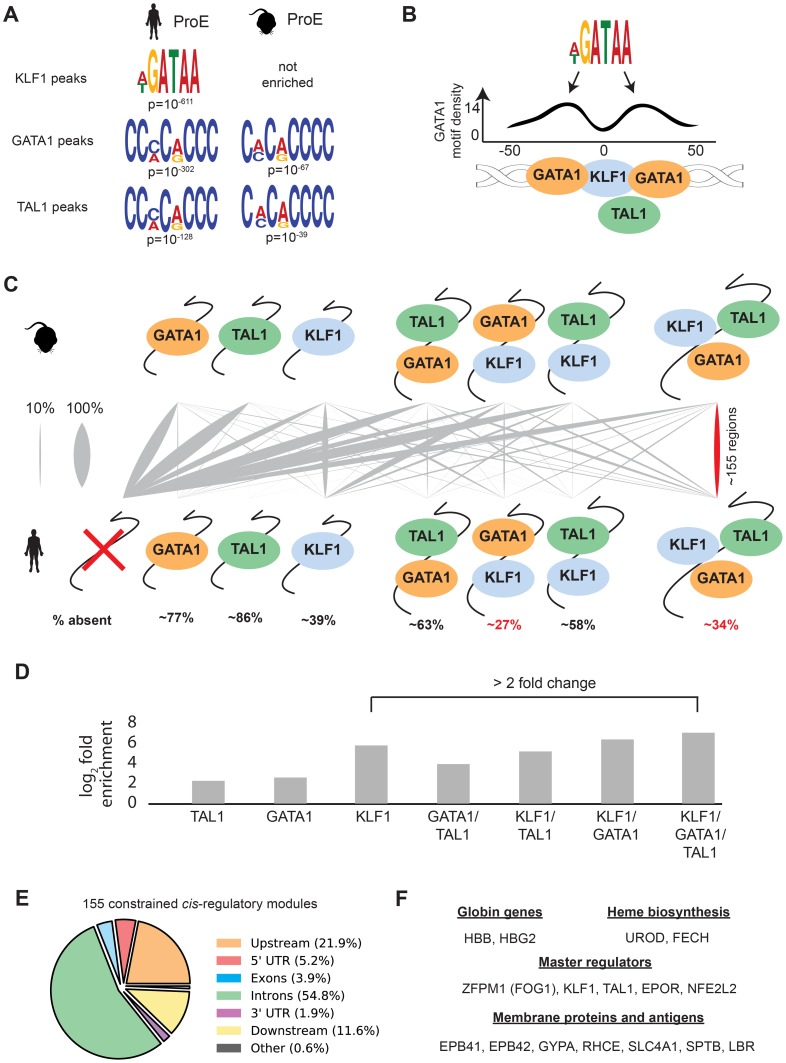
Combinatorial occupancy patterns of transcription factors are strongly conserved.A) In human ProE KLF1 peaks (summit +/- 50 bp), GATA1 motifs were significantly enriched. In human and mouse ProE GATA1 and TAL1 peaks, certain KLF1 motifs were significantly enriched. B) Enrichment of GATA1 motifs identified in A) at non-random distances from the summit of KLF1 occupancy sites reveals that GATA1 and GATA1/TAL1 occupancy may often be found in KLF1-occupied regions. Scales are identical to Fig. 2D. C) For each combinatorial group, the proportion (xi/n) that is mapped from mouse to human is represented as grey lines, where a thicker grey line indicates that a larger proportion. Most regions in mouse are lost in human, but certain combinations (GATA1 and KLF1; GATA1, KLF1, and TAL1) are significantly more conserved than others (p<10−16). % absent is (1- number of mapped regions with no TF occupancy). D) Fold enrichment of combinatorial TF occupancy overlap (observed divided by expected) between species calculated with GAT. E) Genomic localization of the 155 conserved GATA1, KLF1, and TAL1 co-occupied regions. F) A large number of canonical erythroid genes are assigned by proximity to these 155 regions, suggesting that these are co-occupied regions are functionally conserved regulators. Abbreviations used: ProEs, pro-erythroblasts; GAT, Genomic Association Tester.